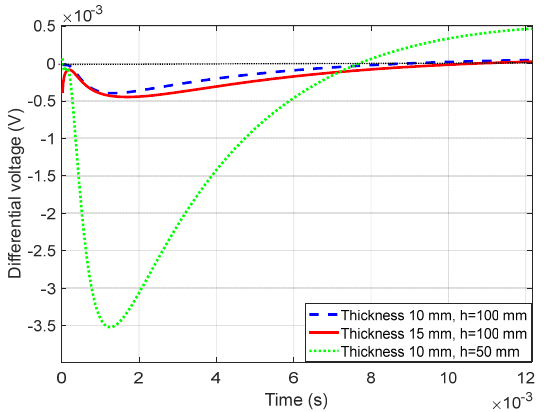
Figure 7. Differential induced voltage curve. The shortening of lift-off not only increases the amplitude of the differential EMF, but also changes the zero crossing time of the signal.